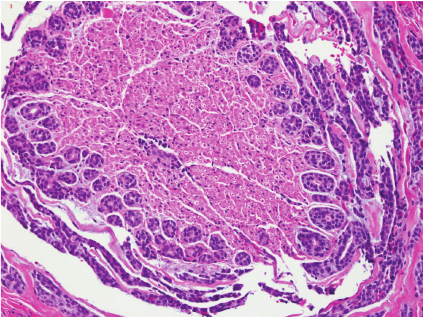
Figure 3: ACC with extensive invasion of the right infraorbital nerve.